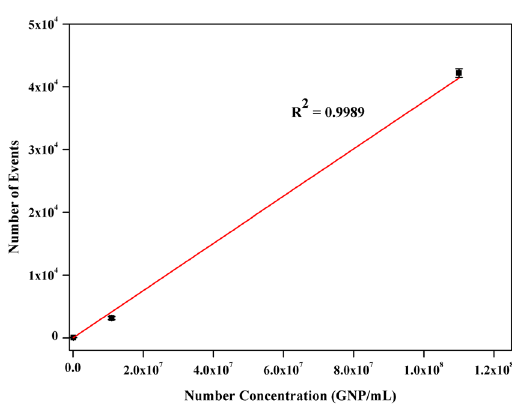
Figure 3. Calibration plot of number of NPs vs. GNP